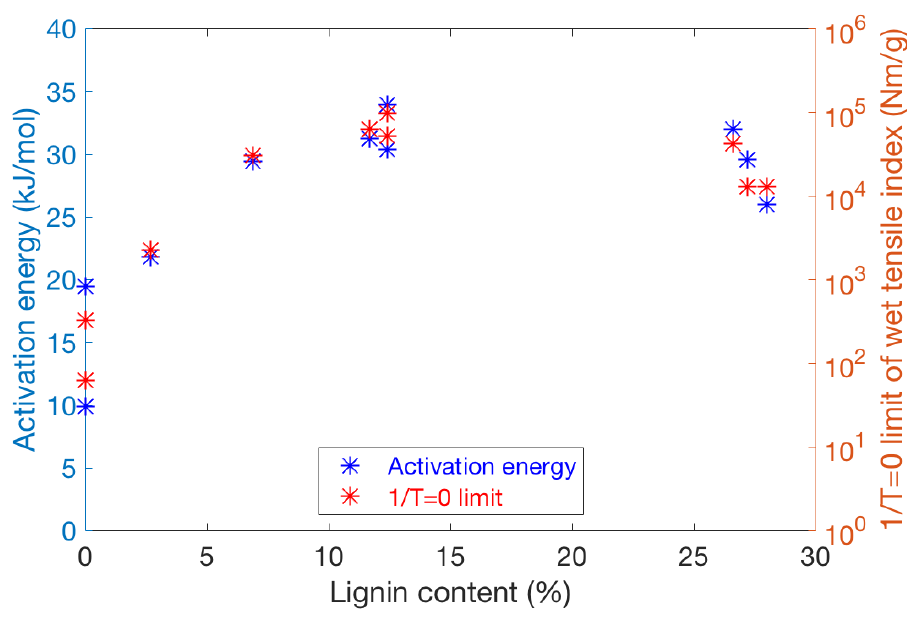
Figure 6. The logarithm of wet tensile strength index plotted against 1/Temperature when pressed with either cylinder press (T = 150 °C, 190 °C; 6 MPa) or steel belt press (T = 230 °C, 270 °C; 8 MPa): ( a ) TMP sheets with preferred MD fibre orientation pressed at an initial solids content of 61%. The points represent an average of 10 data points and their confi- dence intervals. ( b ) Varied pulps and pressing conditions for standard laboratory sheets with uniform fibre orientation. Solids content varies in the range of 50–65%. The overall trend is described by a similar activation energy of 26 kJ mol − 1 as in ( a ).